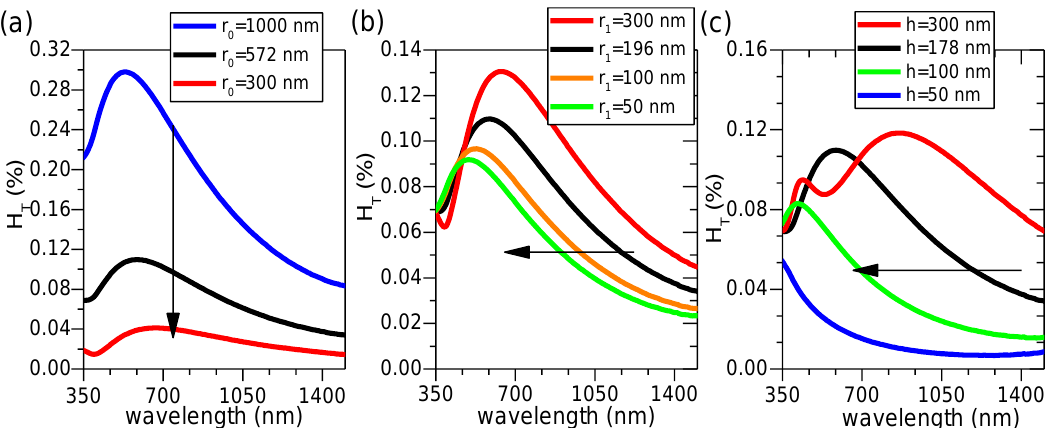
Figure 10. Simulated H T (λ) of FTO nanocomposite containing a single ZnO nanoparticle agglomerate: ( a ) r 0 varies while r 1 and h are fixed to 196 and 178 nm, respectively; ( b ) r 1 varies while r 0 and h are fixed to 572 and 178 nm, respectively; and ( c ) h varies while r 0 and r 1 are fixed to 572 and 196 nm, respectively. The specular light is considered as the central one pixel only.